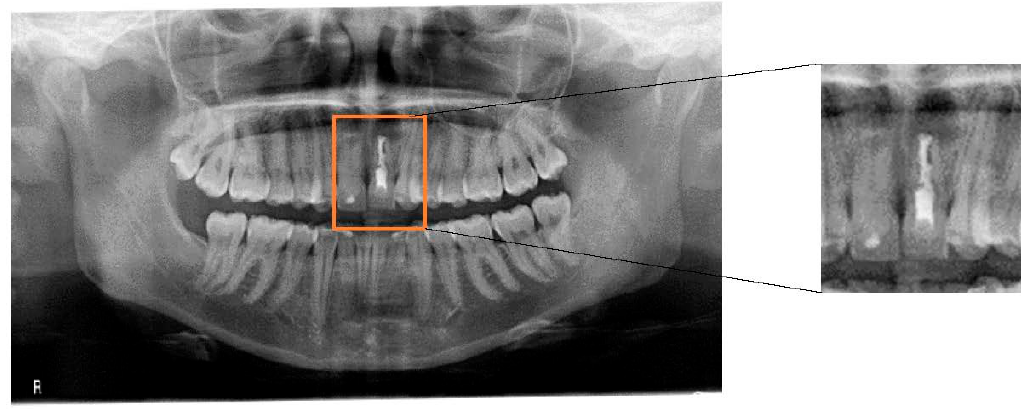
Figure 1. Panoramic radiograph of the patient. A radiolucid periapical lesion on tooth 21 can be observed, which did not disappear after endodontic treatment and apicoectomy.